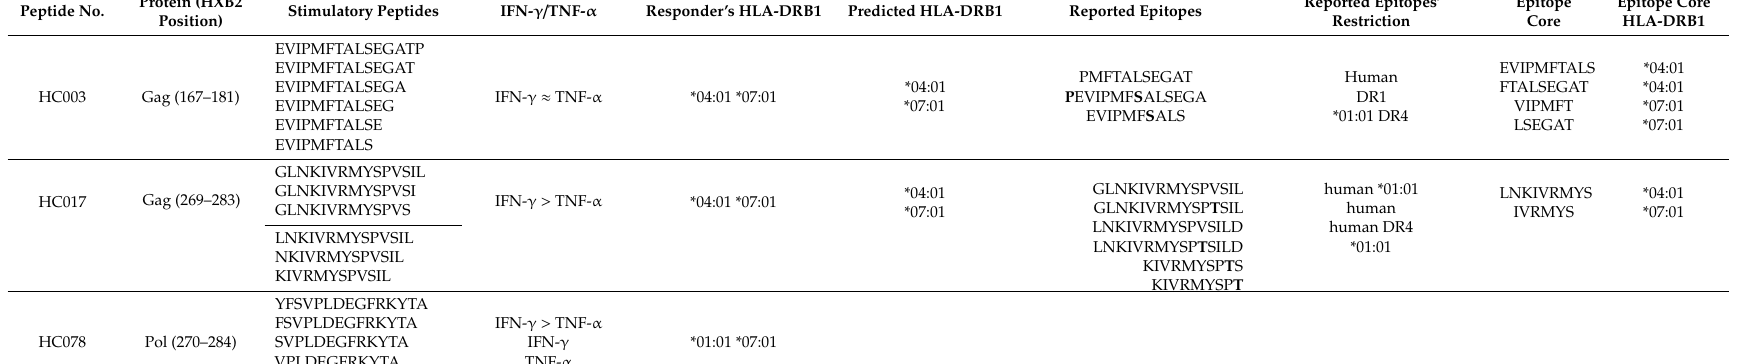
Table 2. Conserved HIV-1-derived HLA-DRB1-restricted epitopes recognized by CD4 + T cells. Peptide